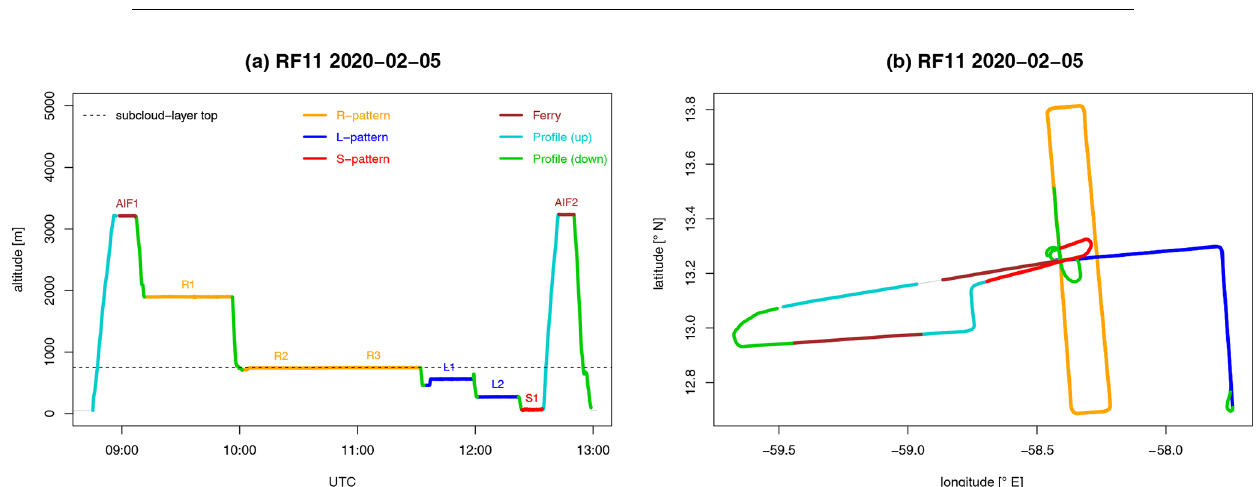
Figure 5. (a) Time–height trajectory and (b) longitude–latitude trajectory of the ATR during RF11 (5 February 2020), illustrating the different patterns and segments of the flight. Also reported is the subcloud-layer top diagnosed from HALO dropsondes (Table